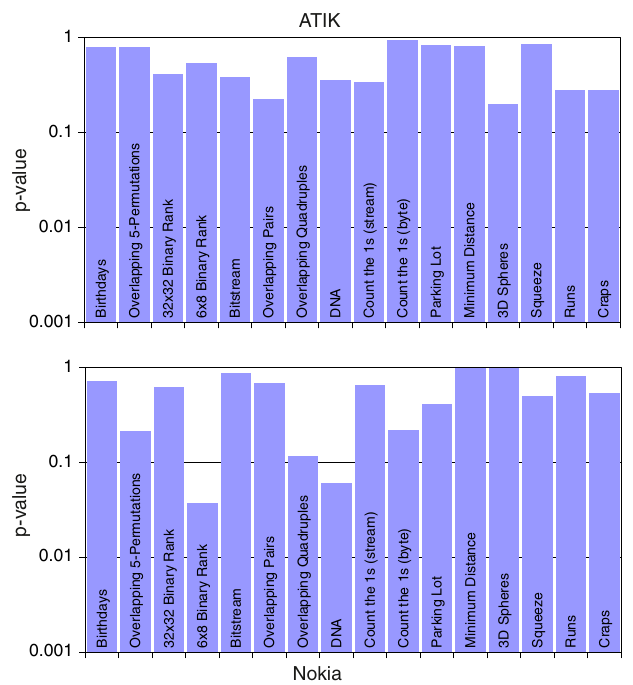
FIG. 8. Test results for some of the Diehard battery of tests for random number generators. The represented p value is the result of a Kolmogorov-Smirnov test of 100 p values. The suite also performs a large number of other tests, which our RNG pass, e.g., 0 . 01 < p × value < 0 . 99